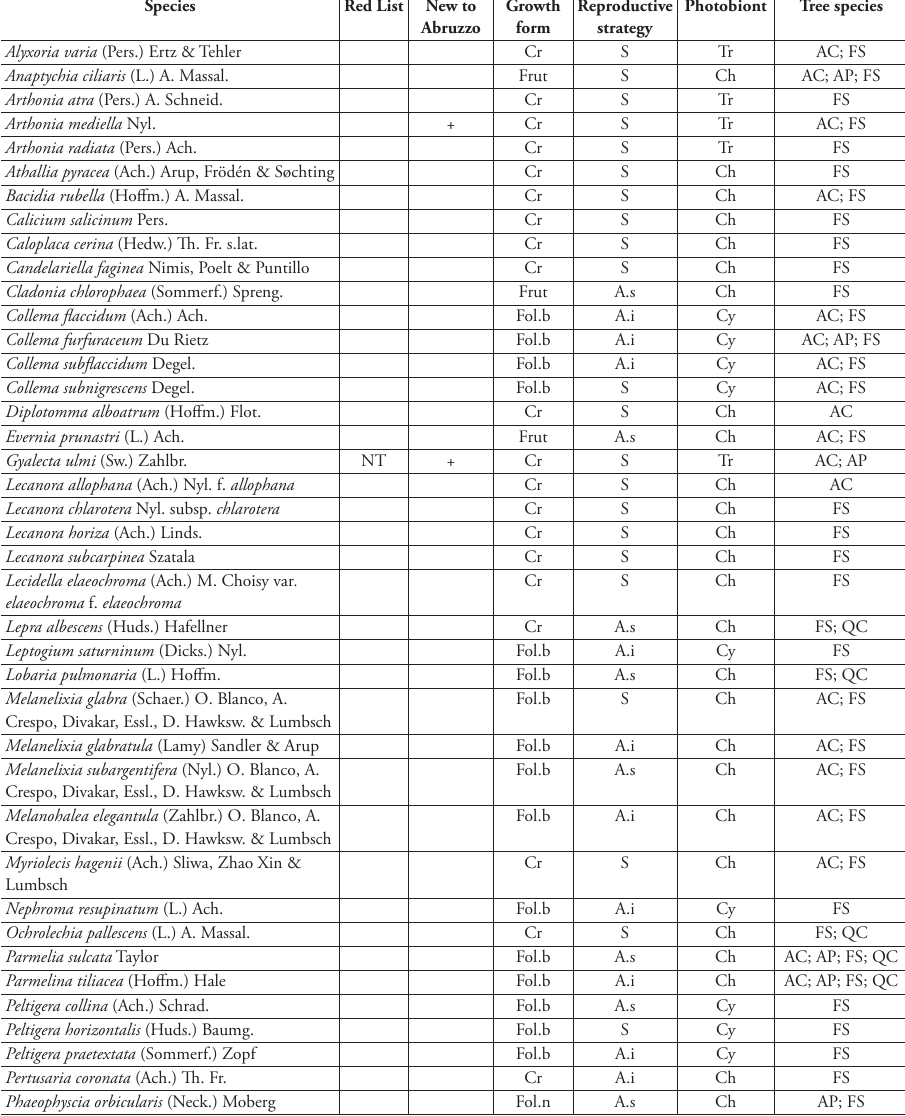
Table 1. Checklist of the epiphytic lichens recorded in the “Bosco di Sant’Antonio”. Species’ biological traits (growth forms and reproductive strategies) were retrieved from Nimis and Martellos (2017). Foliose lichens include both those with narrow ( Physcia -like; Fol.n) and large ( Parmelia -like; Fol.l) lobes; fruticose lichens (Frut); crustose lichens include true crustose (Cr), and squamulose (Sq) species. Reproductive strat- egies are classified as: (a) mainly sexual reproduction by ascospores (S), mainly asexual reproduction by (b) isidia (A.i), and (c) soredia (A.s). The photobiont can be a chlorococcoid green alga other than Trentepohlia (Ch), a Trentepohlioid green alga (Tr) or a cyanobaterium (Cy). Tree species: AC = Acer campestre ; AP = Acer pseudoplatanus ; FS = Fagus sylvatica ; QC = Quercus cerris . Nomenclature follows Nimis (2016), while the conservation importance of the species follows the Italian red list (Nascimbene et al.